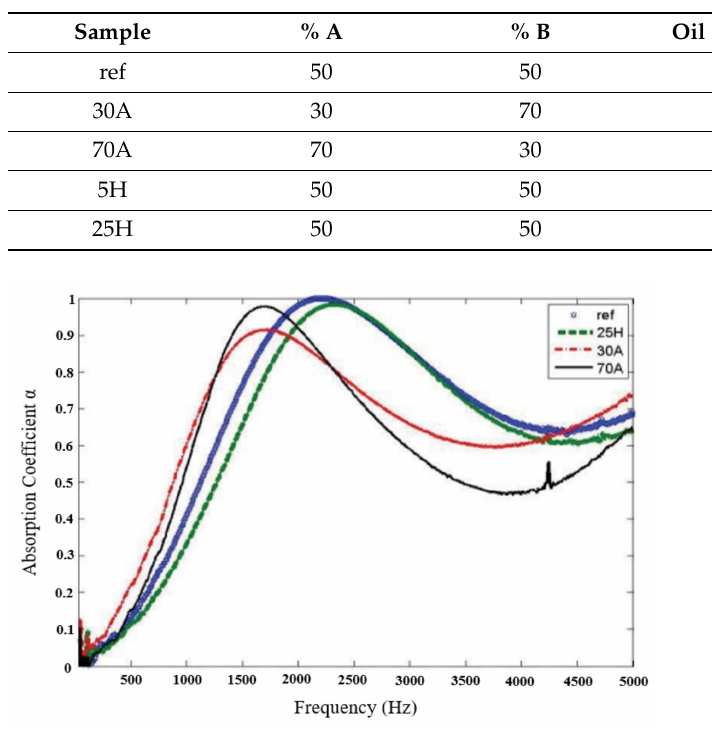
Table 1. Different samples used in the reference study [16].